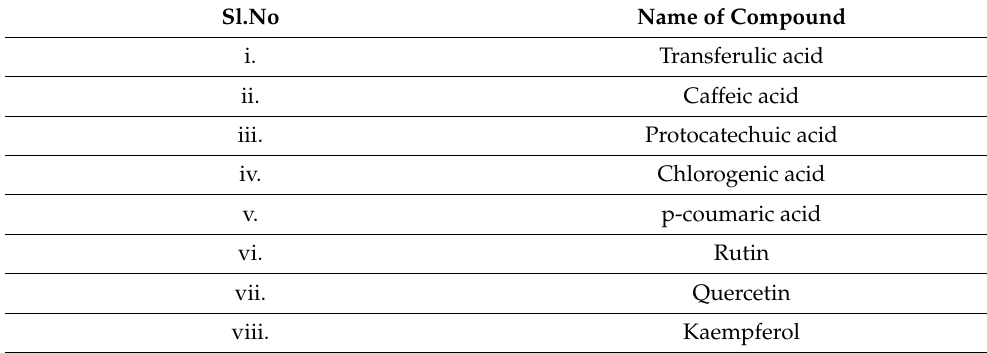
Table 2. List of